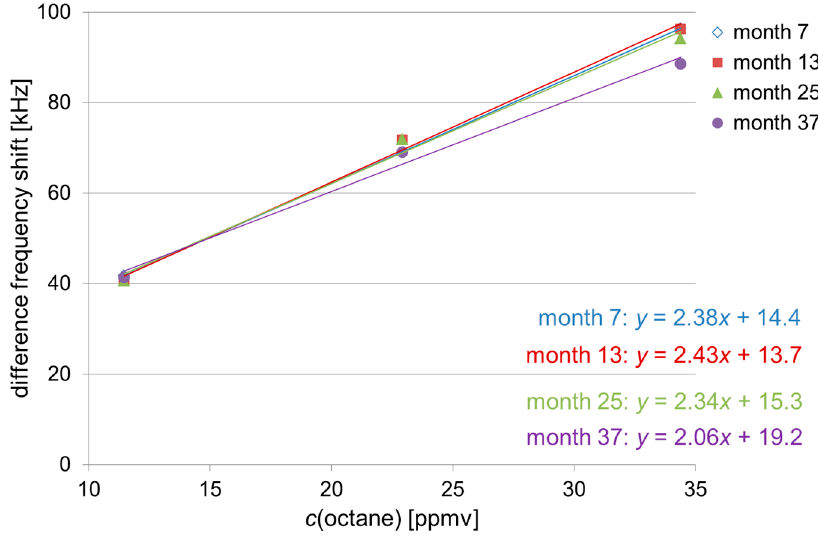
Figure 6. Mean values of sensor 1 (PBMA coating) obtained with octane samples at the concentrations of 11.5 ppmv, 22.9 ppmv, and 34.4 ppmv at (semi-)annual intervals: As month 1 is missing, year 1 is represented by month 7. The lowest and highest concentrations were measured in triplicate, the medium concentration in duplicate. For the sake of clarity, error bars are not included. Regression lines were calculated with y = difference frequency shift [kHz] and x = c (octane) [ppmv].